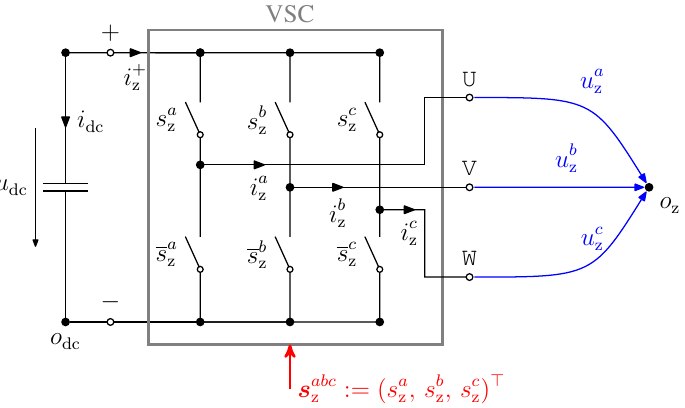
Figure 6. Electrical circuit of voltage source converter (VSC) with ideal switches and DC-link (z The stator-side converter feeds the electrical machine (generator) with the phase voltages u abc , while the filter-side converter applies the phase voltages u abc s